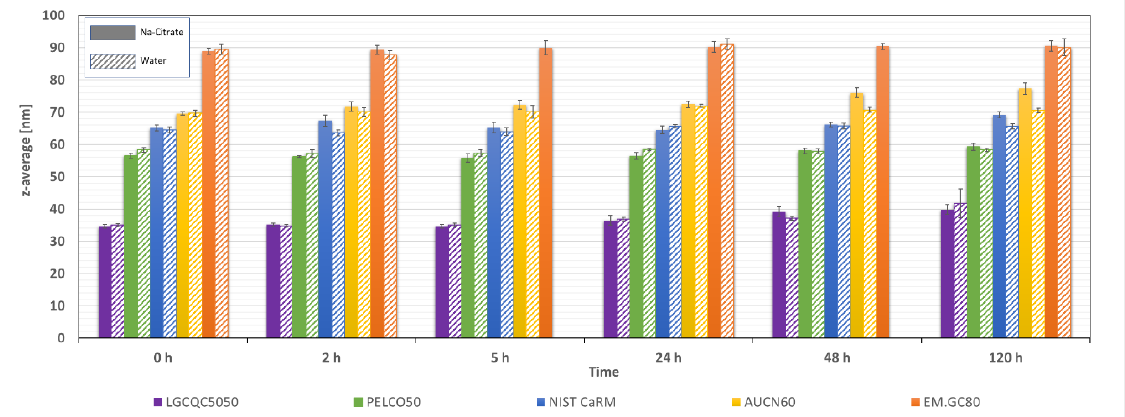
Figure 3. Assessment of suspensions stability. Measurement of z-average (DLS) at various time intervals after dilution of AuNP suspensions with ultrapure water or 1.5 mM sodium citrate.